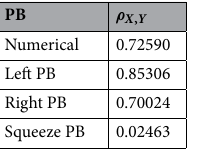
Table 1. Pearson correlation coefficient between standard error σ L and loss function J L